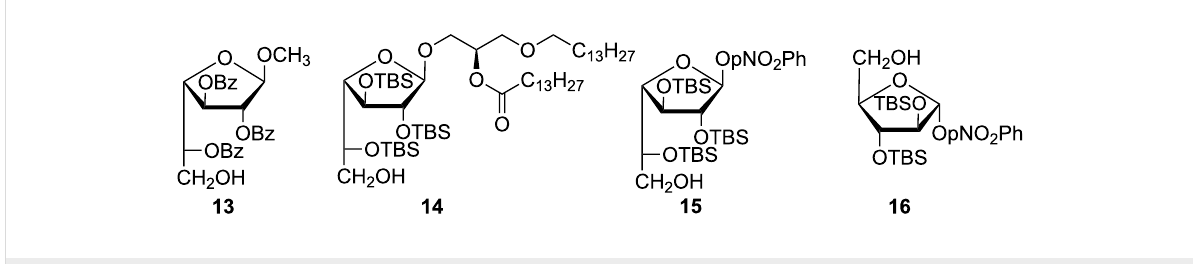
Figure 3: Furanosic derivatives with free primary hydroxy